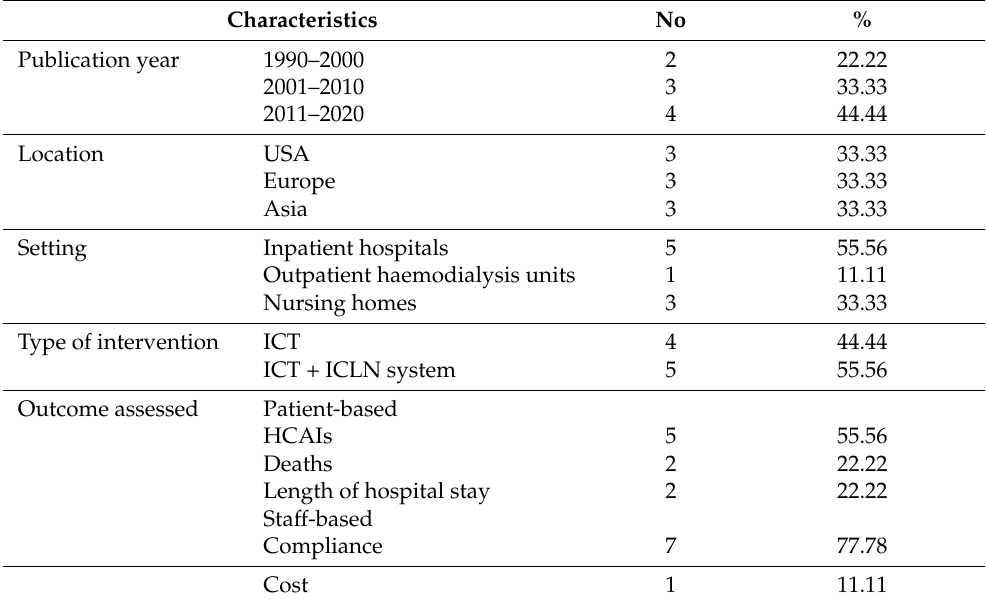
Table 1. Characteristics of included studies ( n =